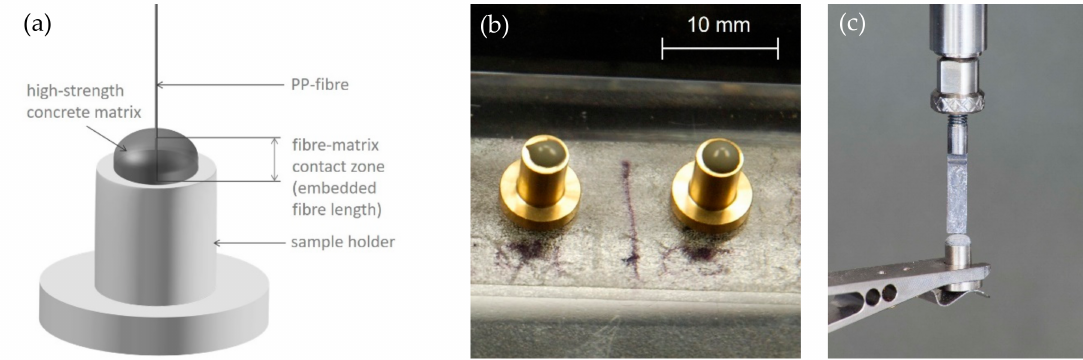
Figure 2. ( a ) Schematic single-fiber model composite, ( b ) real specimens with high strength matrix and ( c ) setup of the dynamic single-fiber pull-out experiments